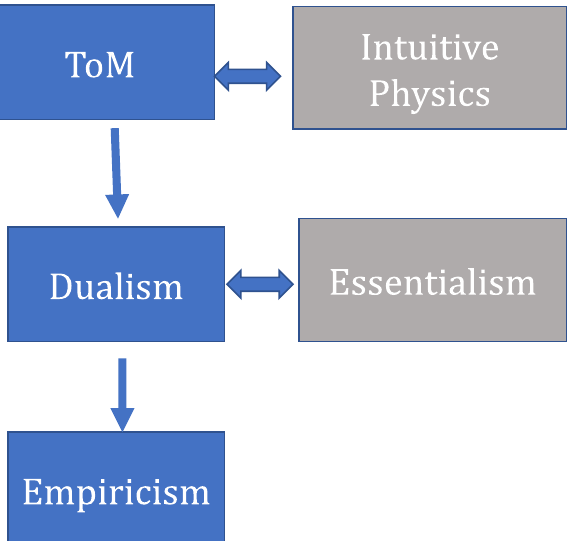
Figure 1. The hypothesized links between ToM, Dualism and